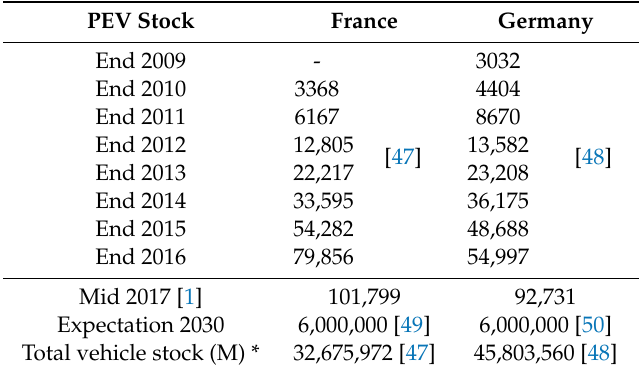
Table 1. Data and parameters used for di ff usion model